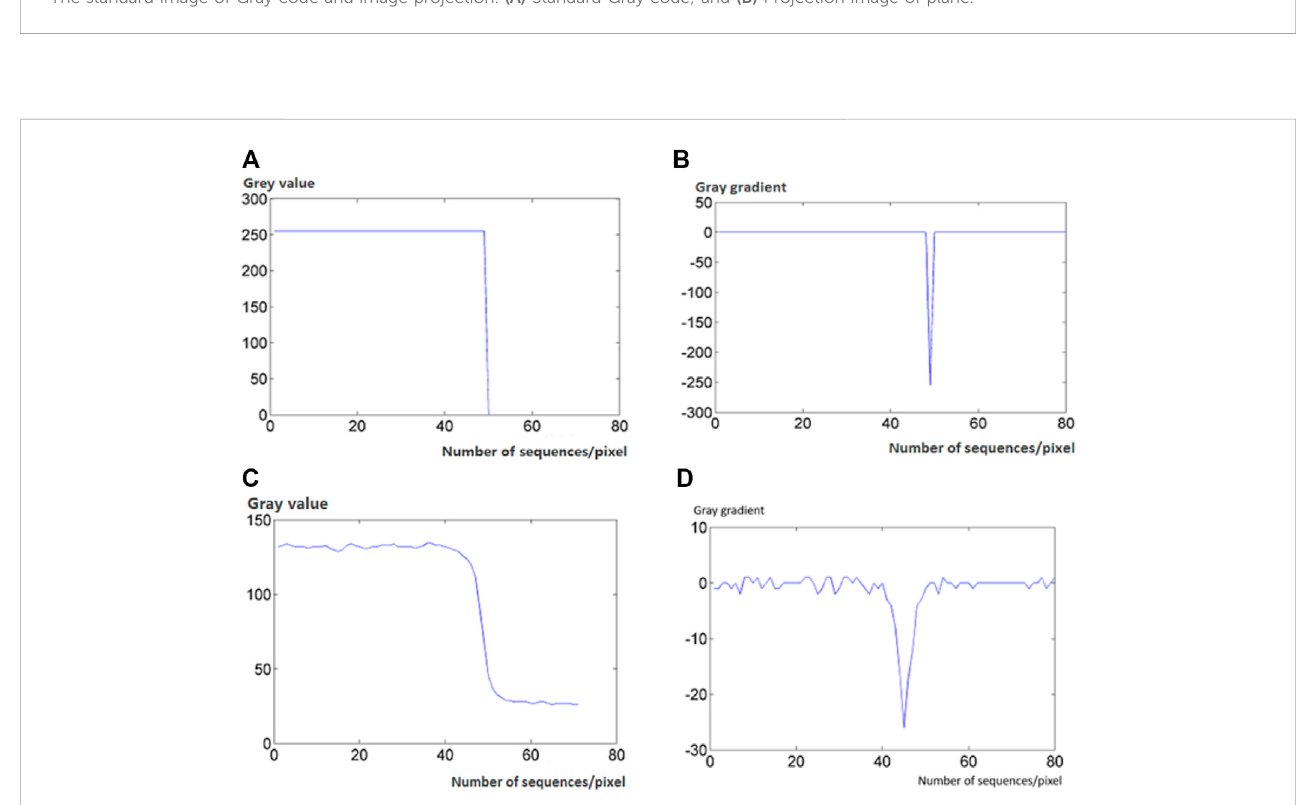
FIGURE 6 Grey value and grey gradient curve of fringe edge. (A) Grey value of standard Gray code; (B) Grey gradient of standard Gray code; (C) Grey value of projection plane with Gray code; and (D) Grey gradient of projection plane with Gray